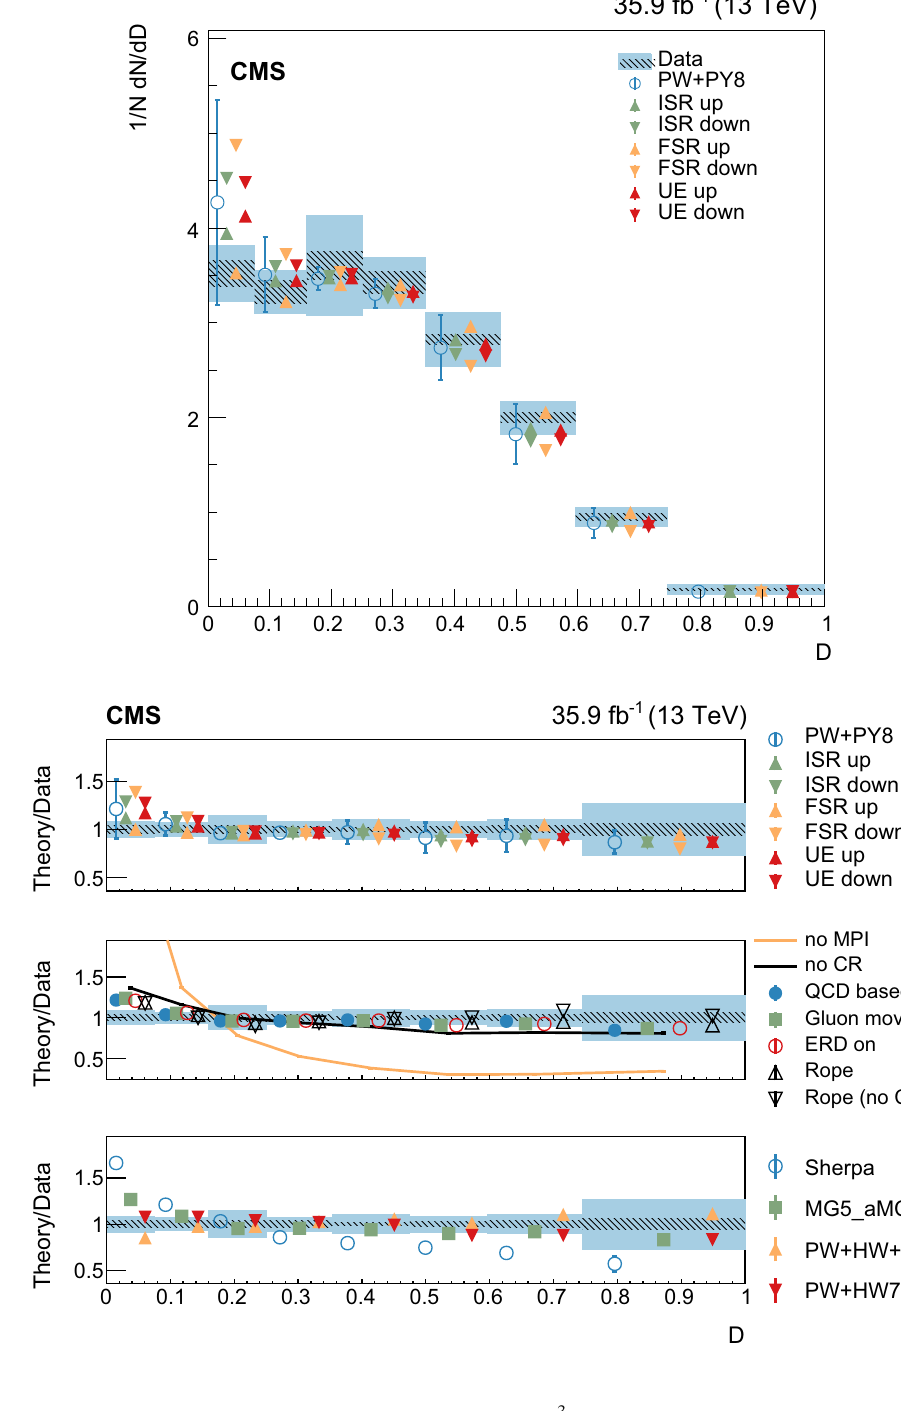
Fig. 13 Normalized differential cross section as function of the D variable, compared to the predictions of different models. The conventions of Fig. 4 are